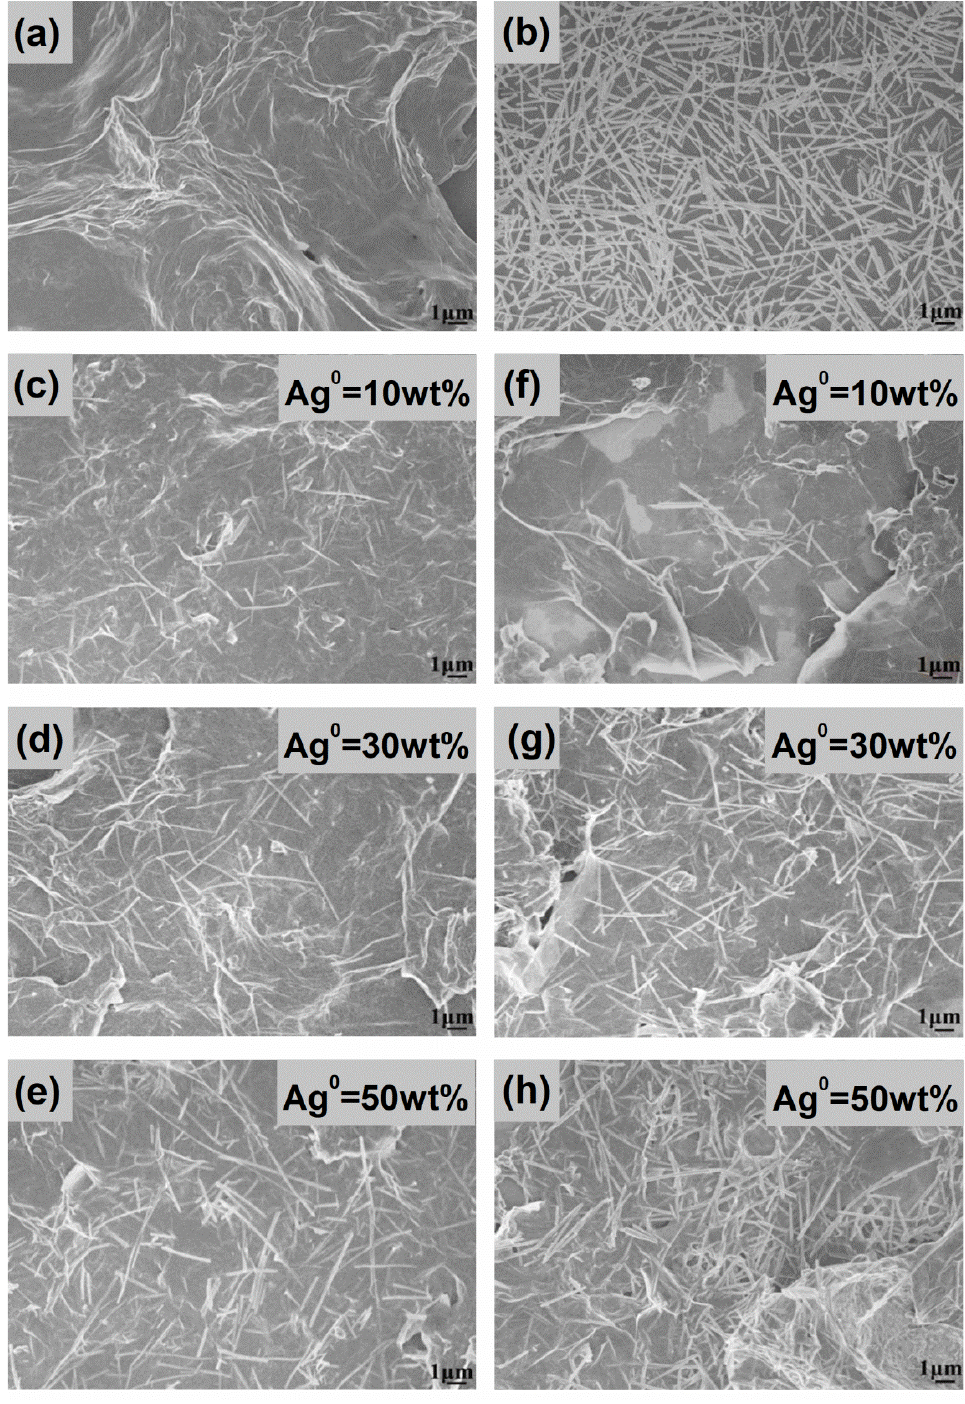
Figure 2. SEM images of ( a ) pristine f -rGO DBSA ; ( b ) preformed AgNWs; ( c – e ) hybrid materials of f -rGO DBSA /AgNWs physical mixture; and ( f – h ) f -rGO DBSA /AgNWs in situ, with silver loadings of 10, 30, and 50 wt %, respectively.